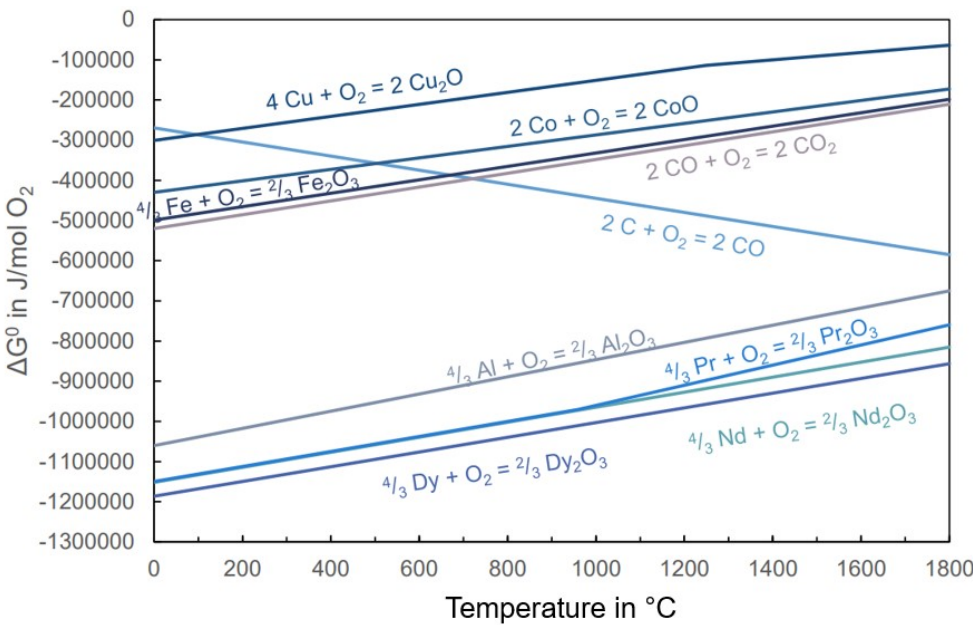
Figure 4. Richardson–Ellingham diagram for selected